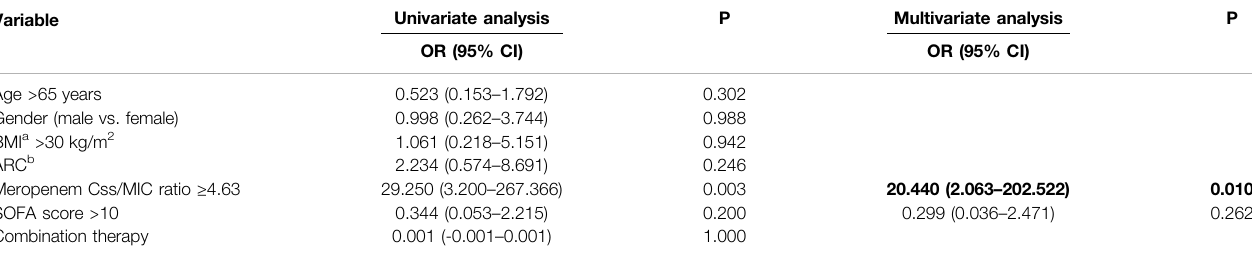
TABLE 3 | Univariate and multivariate logistic regression analysis of variables associated with favorable clinical outcome ( n (cid:1) 44). Univariate analysis P Multivariate analysis PVariable